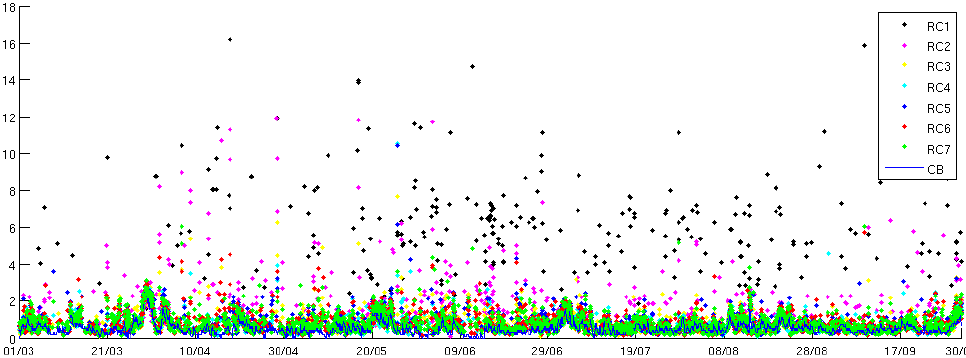
Figure 10. HF radar data of the Salou antenna for all of the Range Cells (RCs) compared with the CB measured data. Time series data are for 2014.